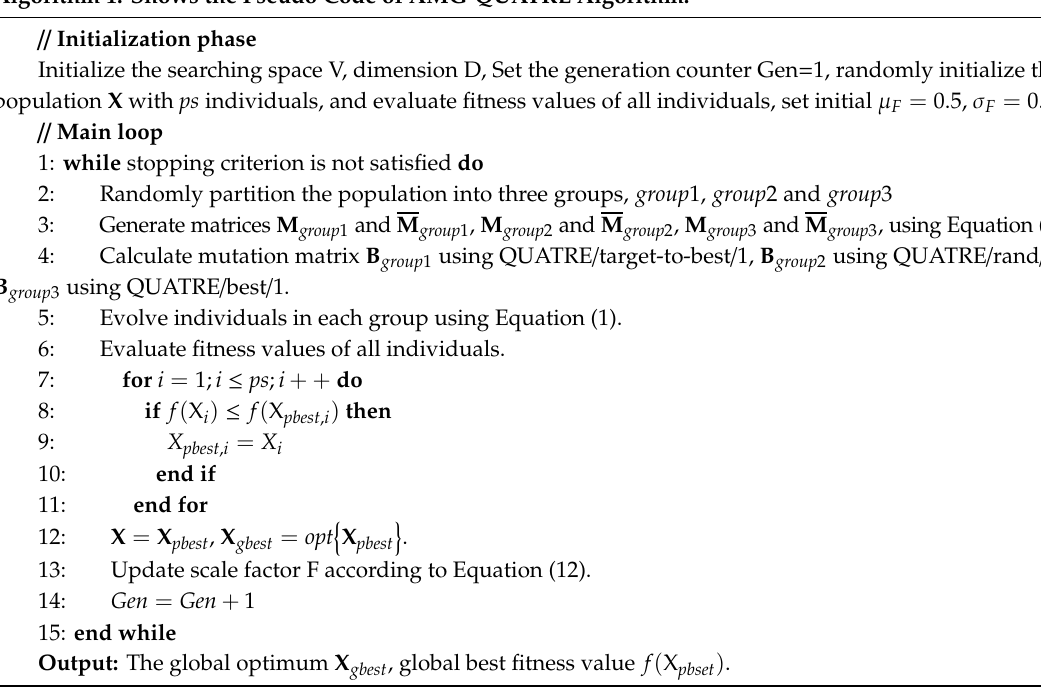
Algorithm 1. Shows the Pseudo Code of AMG-QUATRE Algorithm. // Initialization